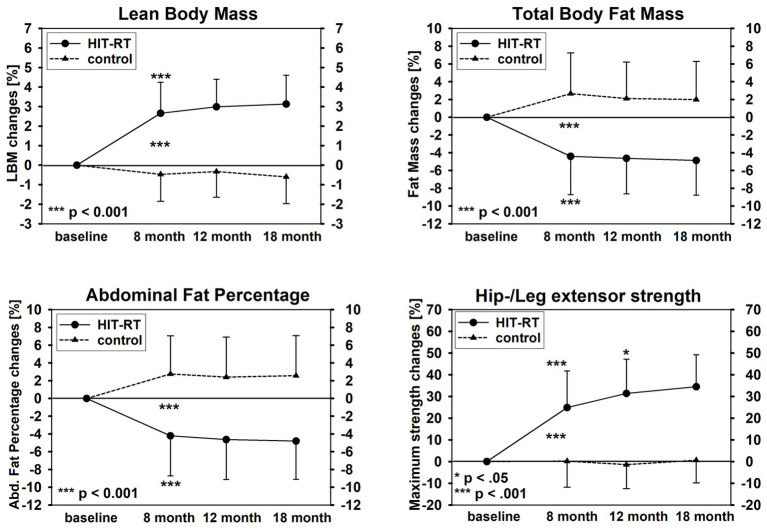
Changes of lean body mass (upper left graph), total body fat mass (upper right graph), abdominal fat percentage (lower left graph), and maximum isokinetic hip/leg-extensor strength (lower right graph).